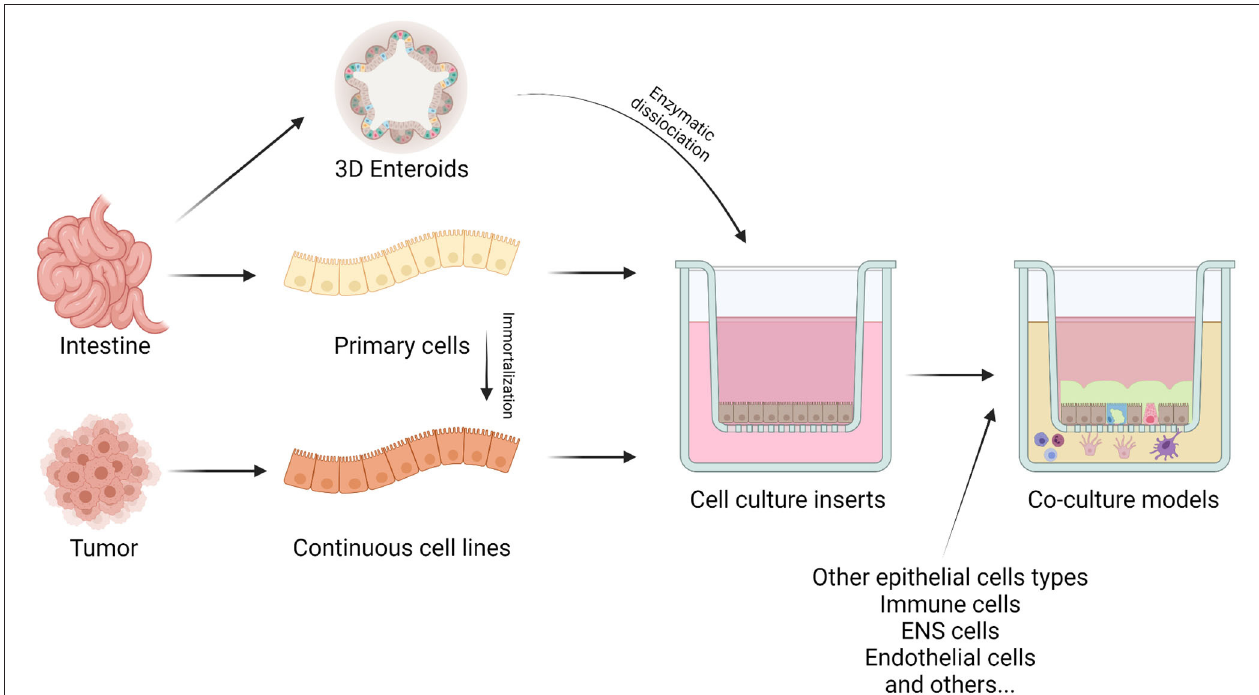
FIGURE 1 | The figure represents the different cell sources for in vitro studies. Epithelial cells can derive directly from intestinal tissue or from tumors. The intestine allows the isolations of primary cells or stem cells to produce enteroids and organoids. On the other hand, intestinal tumors generate continuous cell cultures. These can also be obtained by immortalization techniques of primary cells. Cells can be seeded on specific inserts, alone or in co-culture with other cell types to create either monolayers or a more representative intestinal barrier model, respectively. Created with